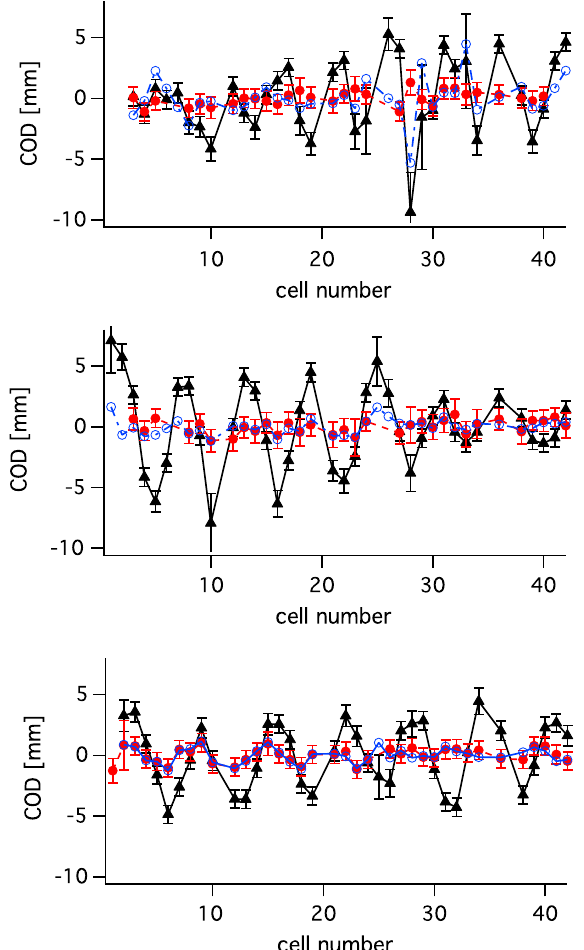
FIG. 8. Horizontal closed orbit correction at 14.3 (top), 16.1 (middle), and 18 . 0 MeV =c (bottom) where the horizontal tunes are approximately 8.4, 7.5, and 6.5, respectively. The closed orbit distortion measured before (black triangles) and after correction (red filled circles) is shown along with the predicted correction based on the response matrix (blue open circles). Error bars include the standard deviation of the shot-by-shot variation of the closed orbit as well as the BPM offset based on survey